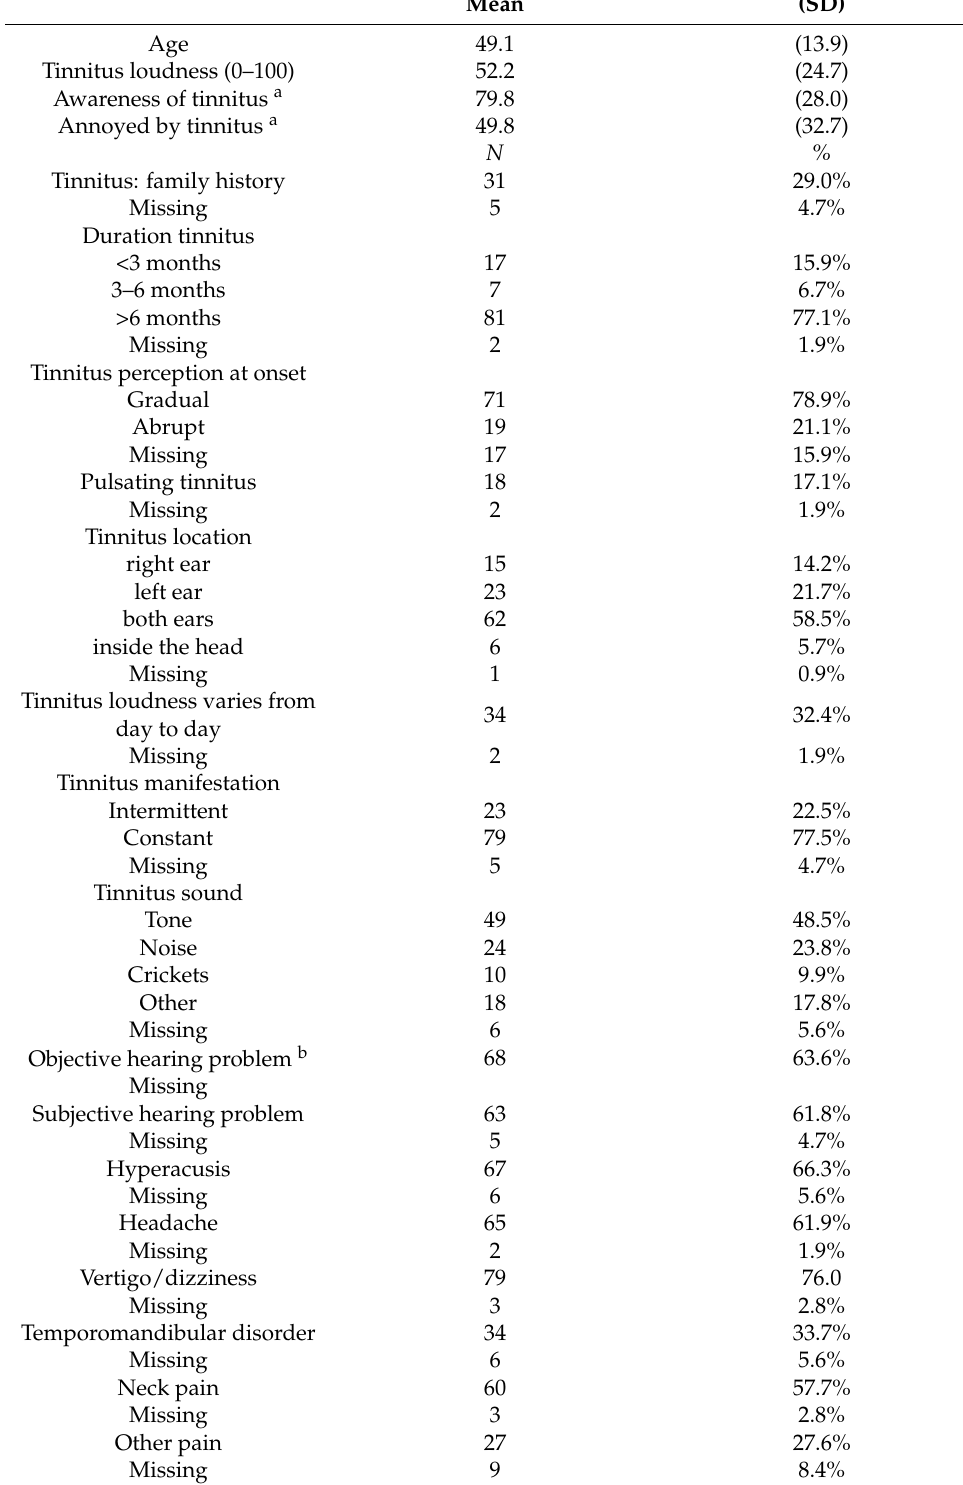
Table 1. Sociodemographic and clinical